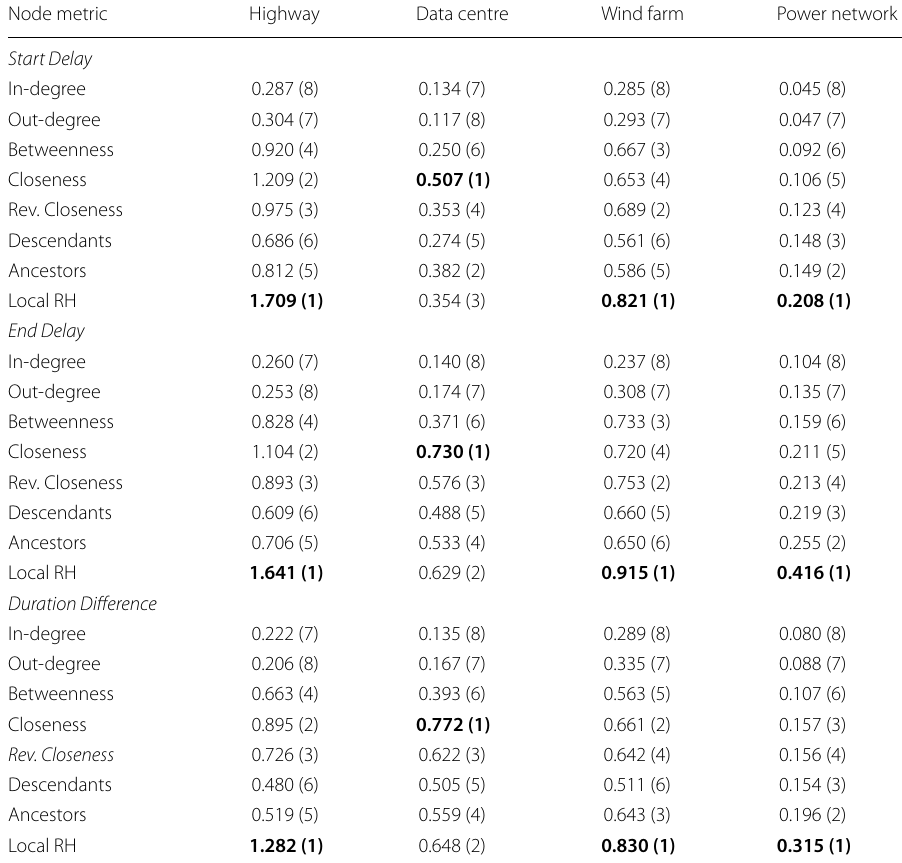
Table 4 Comparison between the local RH score and seven other node